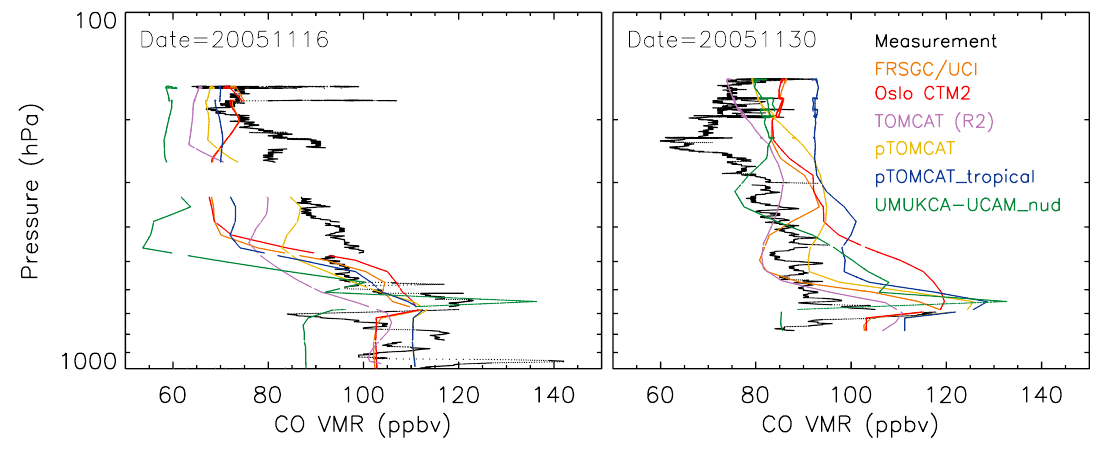
Fig. 9. A comparison between modelled and measured CO mixing ratios along the Egrett flight track for 16, and 30 November 2005. The measurements were made during the Active campaign in Darwin,